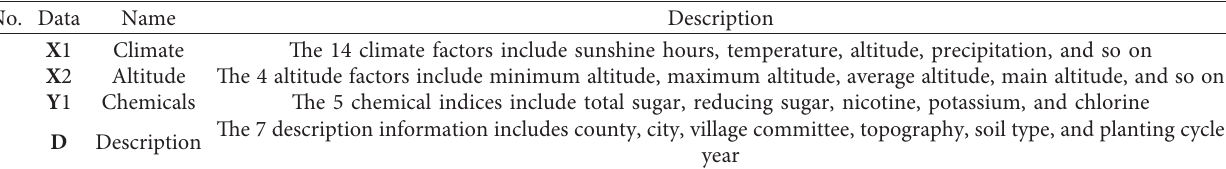
Table 1: The details of the example data of climate, altitude, and chemical compositions, respectively.